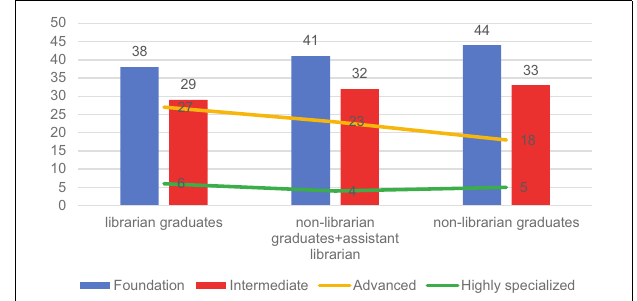
FIGURE 10 | Differences at highly specialized level.